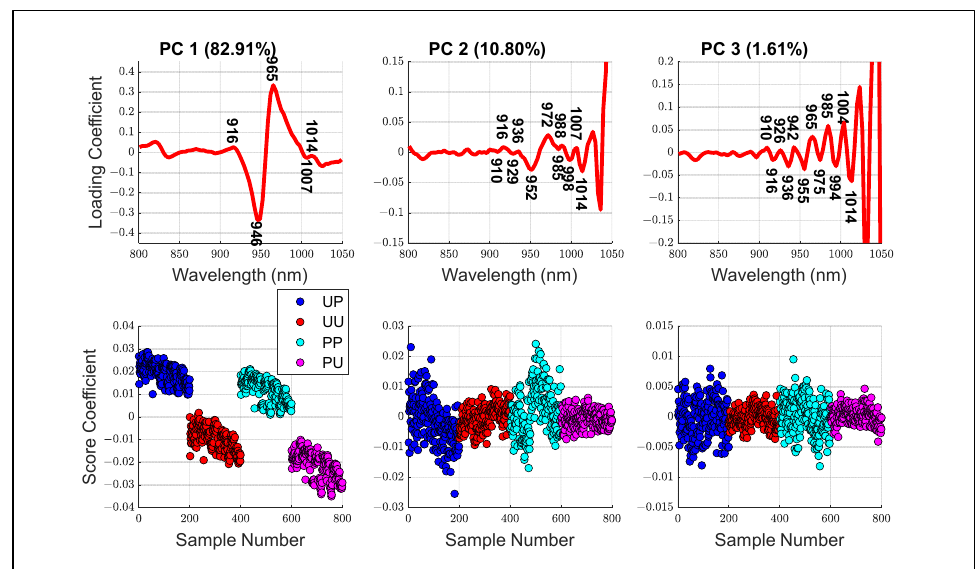
Figure 5. Principal Component Analysis (PCA) loading and score plots with variance explained at the top of each loading plot. For score plots, Blue (Unpeeled Polarized, 1–200), Red (Unpeeled Unpolarized, 201–400), Cyan (Peeled Polarized, 401–600) and Magenta (Peeled Unpolarized, 601–800 kiwifruit) are shown. For each principal component plot, maxima and minima wavelengths in the range of 900 to 1020 nm were identified for use with the aquaphotomics analysis. There was a clear separation between the polarized and unpolarized configurations in PC1, where there was a slight tendency for peeled configurations to shift negatively. This appears to be due to a negative correlation at 946 nm, a wavelength corresponding to a free water state ( 𝑆 (cid:2868) ), de ‐ scribed as water molecules with a free OH (cid:2879) functional groups. Separation between polar ‐ ization states shifted positively at 965 nm, a wavelength corresponding to water molecules bonded with one hydrogen bond. Trends with the higher PCs were not so obvious. Average SSC difference spectra (SNV + 2D absorbance) were calculated for each con ‐ figuration (Figure 6) by subtracting the average spectra for all groups from the average spectra of the Low SSC group. The changes for the polarized light configurations were at 946 and 965 nm, an increase and decrease in SNV + 2D absorbance, respectively, as SSC increased. The unpolarized light configurations had similar changes occurring at 949 nm and 968 nm with the unpeeled configurations having extra features at 975 nm and 978 nm, possibly caused by the presence of the skin. All minor maxima and minima in each con ‐ figuration were considered in the subsequent aquaphotomics analysis.